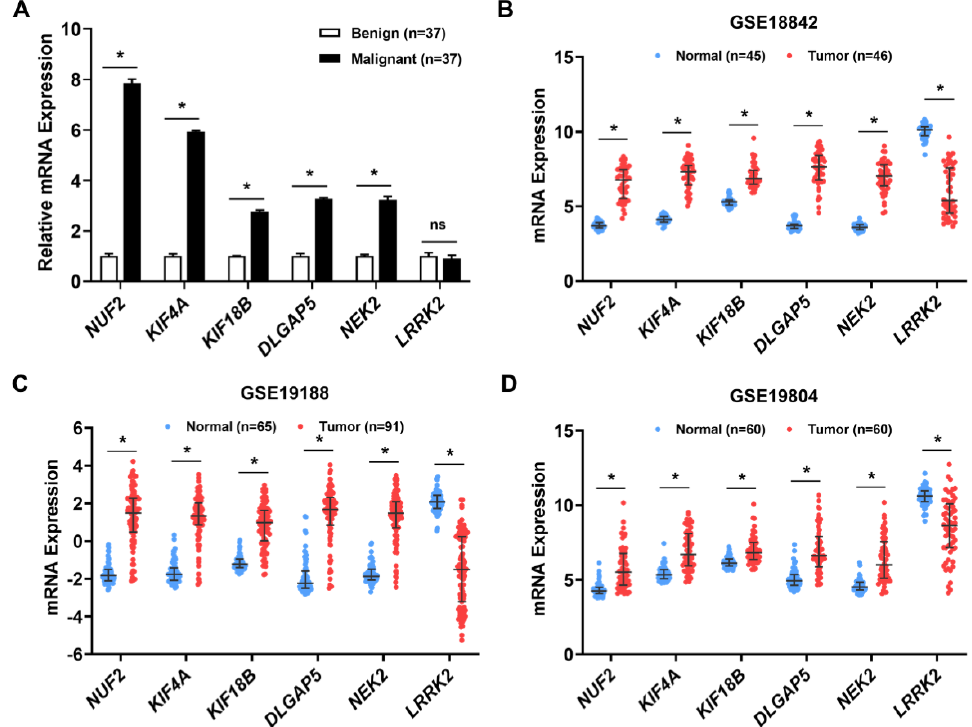
Figure 6. Validation of the candidate DEMG expressions. Clinical validation in benign ( n = 37) and malignant ( n = 37) lung tissues was analyzed by quantitative reverse transcription polymerase chain reaction ( A ). * p < 0.05 vs. benign tissue, ns = not significant. The DEMG expressions were examined in the following three Gene Expression Omnibus datasets: GSE18842 ( B ), GSE19188 ( C ), and GSE19804 ( D ), compared between normal and tumor tissues. * p < 0.05 vs. normal tissue.